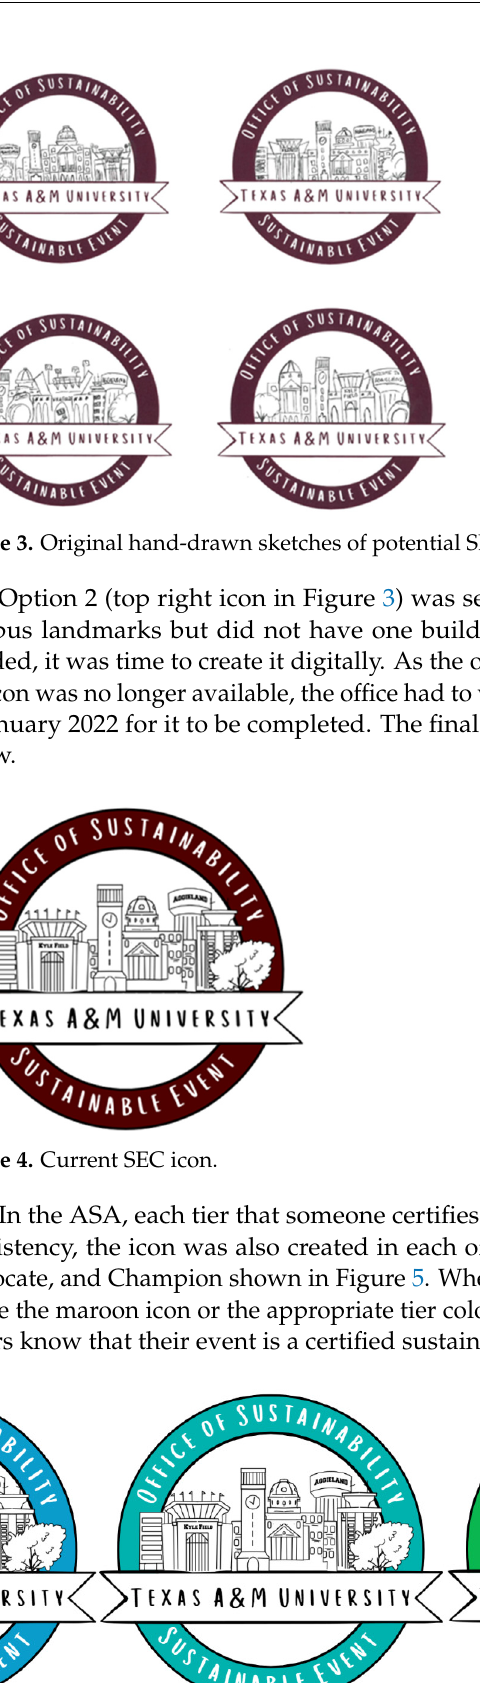
Figure 5. Current SEC icons based on tier certified (Supporter, Advocate, and Champion).